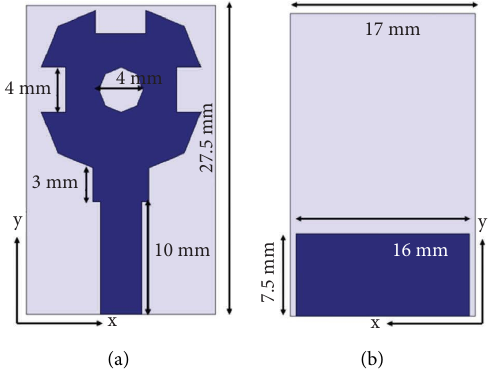
Figure 1: Layout of the monopole antenna: (a) front side and (b) back side.